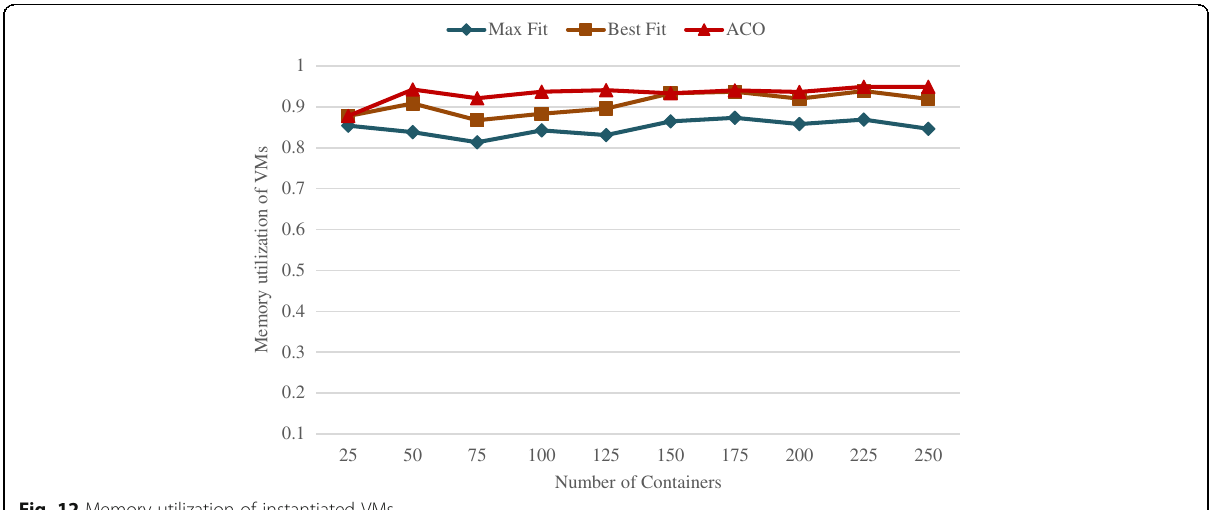
Fig. 12 Memory utilization of instantiated